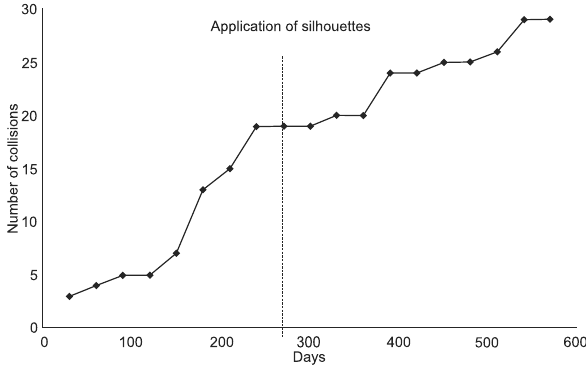
Figure 5. Total number of bird fatalities resulting from bird-window collisions in windows without and with bird-of-prey decals on